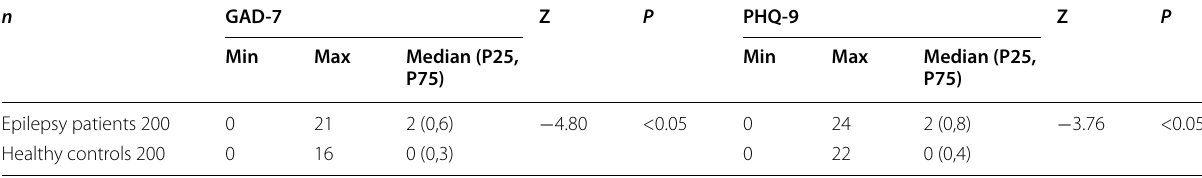
GAD-7 Generalized Anxiety Disorder-7, PHQ-9 Patient Health Questionnaire